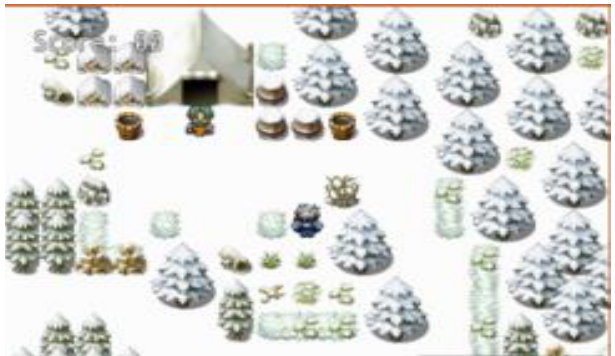
Figure 7. The frozen mountains and the wood cutter. The wood cutter helps the player with the assigned task but also assigns him with more tasks and puzzles.